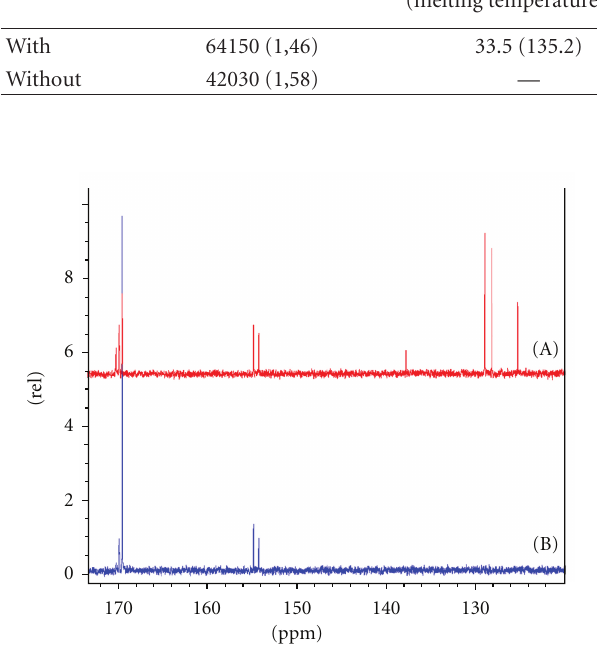
Table 5: Characteristics of copolymer PTMC-PLA-PTMC synthesised with and without protector ( α -methylstyrene). Protector